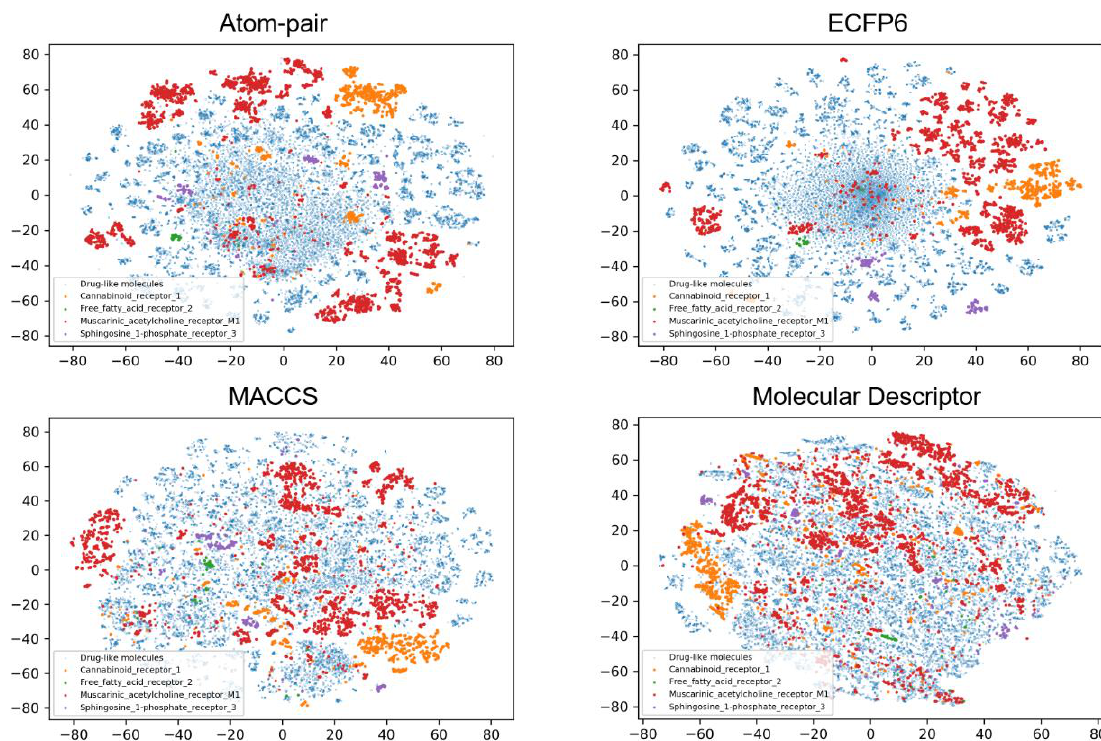
Figure 2. t-SNE method was used to visualize the chemical distribution of allosteric modulators from four subtypes of class A GPCRs according to Atom-pair, ECFP6, MACCS fingerprints, and molecular descriptors.